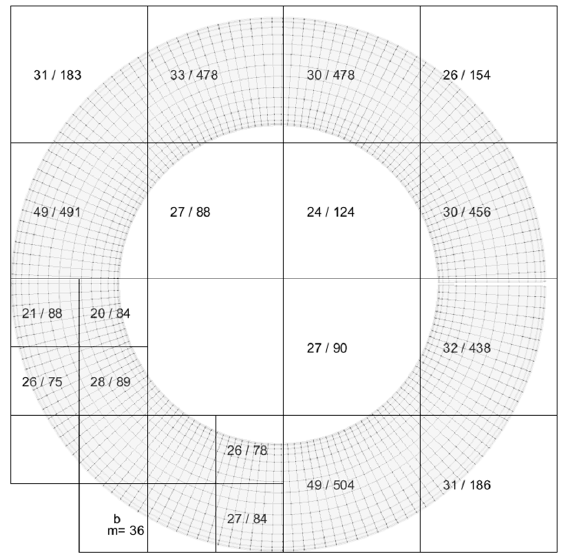
Figure 6. The rank between the field box b and all the other source boxes (the c boxes). The number of the DOFs in the field box b is 36. For all the far sources boxes c it is reported in the format X/Y format, which stands for the rank (X) of the matrix 𝐋 𝐛𝐜 and the number of sources DOFs (Y). Note that the X/Y information is omitted for the near boxes.